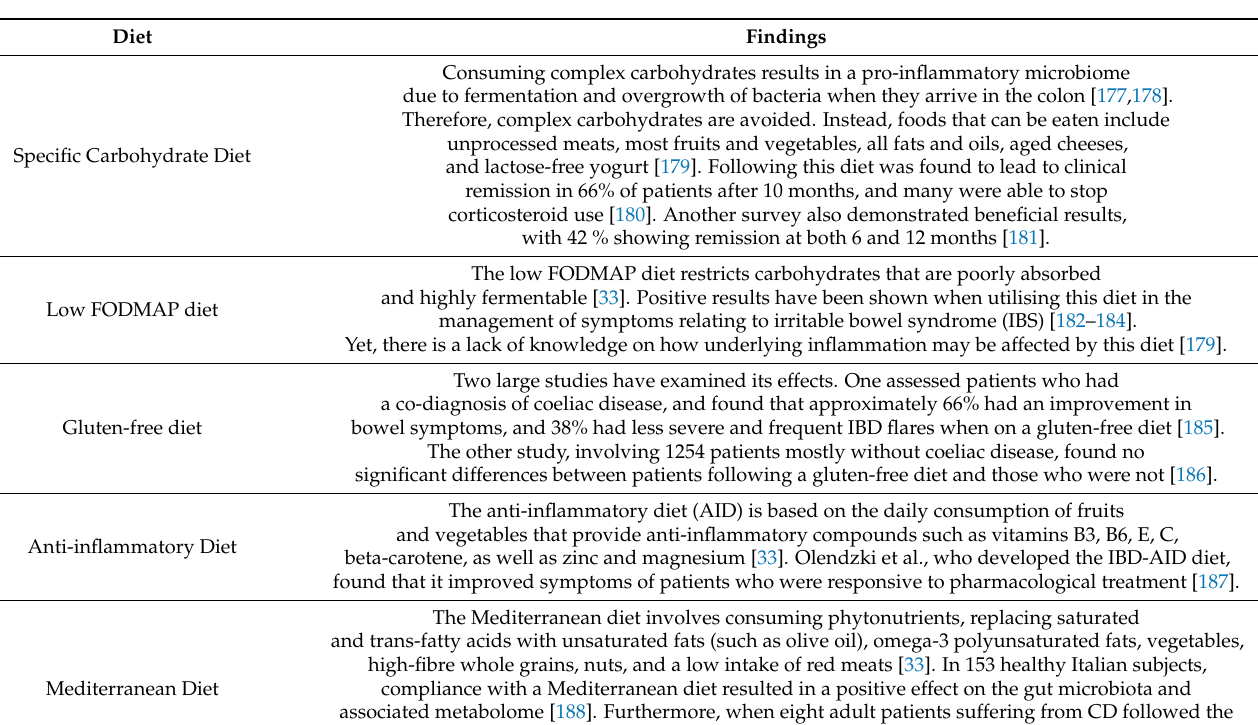
Table 9. The benefits of specific diets in IBD.